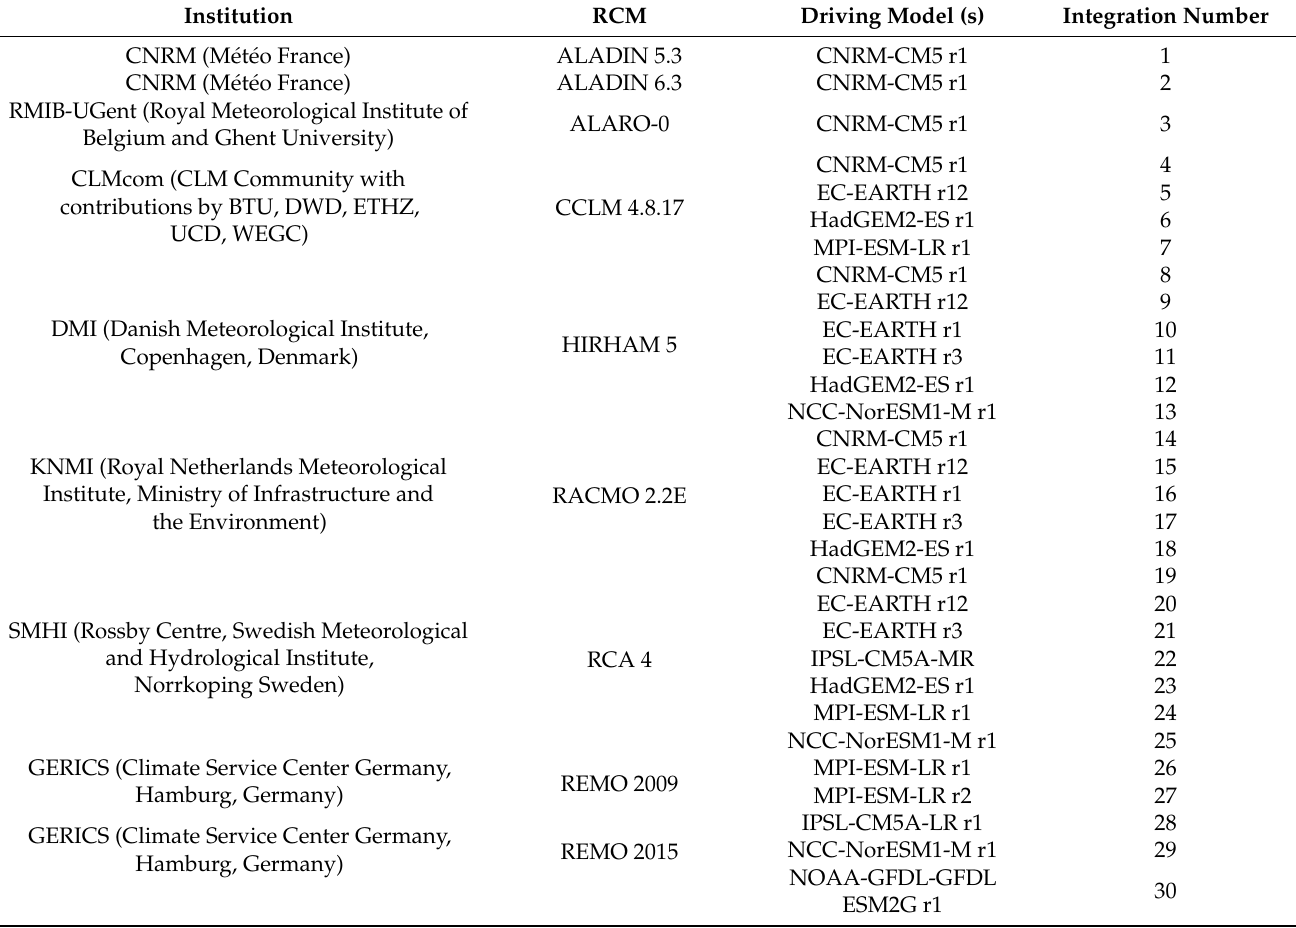
Table 1. Overview of RCMs used in the present study. Numbers in the last column are used to distinguish different RCM–GCM combinations in this paper (references for each RCM are given in Reference